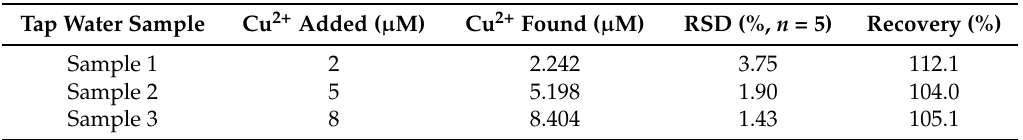
Table 1. Recovery test of Cu 2+ in tap water 1